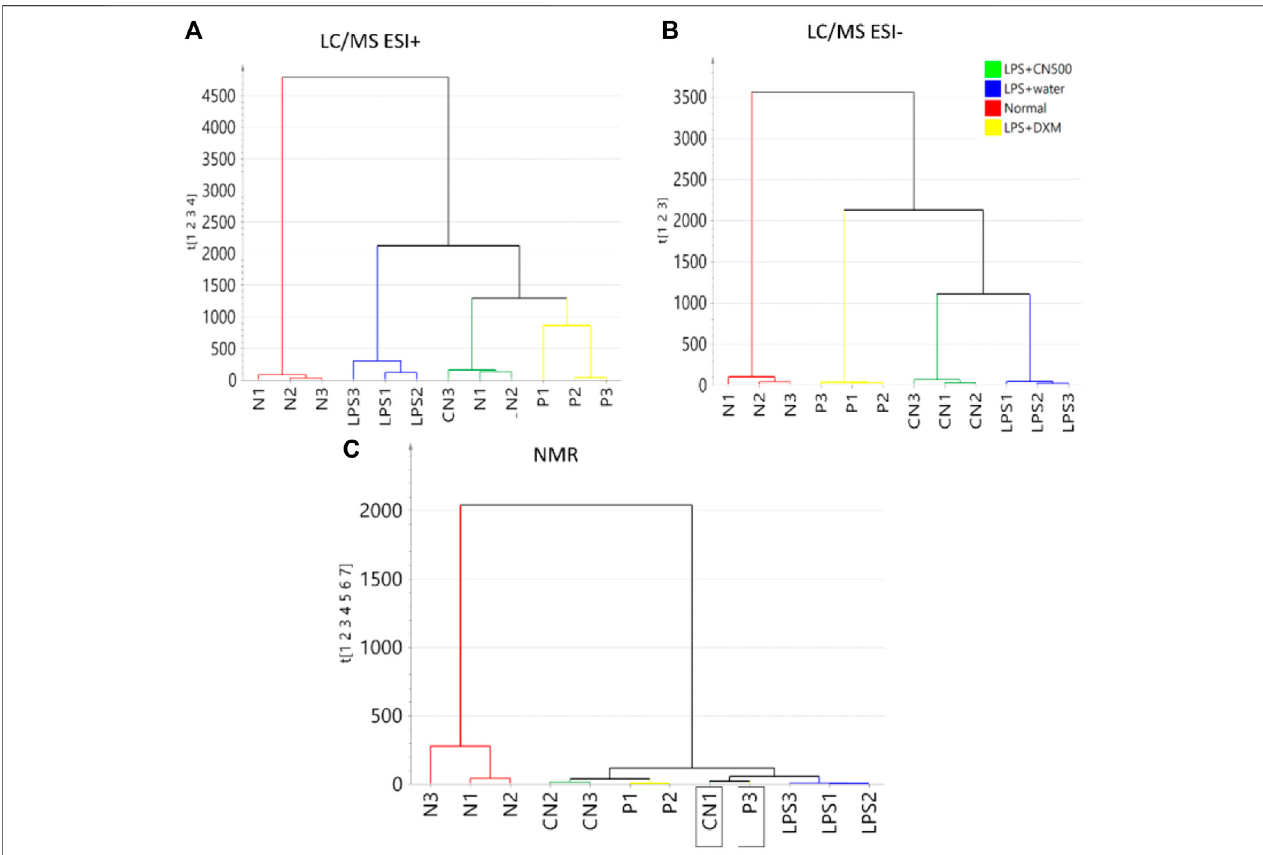
FIGURE 3 | HCA of sera metabolite pro fi les of the four groups ( N (cid:2) normal; LPS (cid:2) LPS + water; CN (cid:2) LPS + CN500 and P (cid:2) LPS + DXM; n (cid:2) 3) with a separate analytical platform of (A) LC/MS (ESI+), (B) LC/MS (ESI-), and (C) 1H NMR. The labelled boxes indicate samples that were mixed classi fi ed.